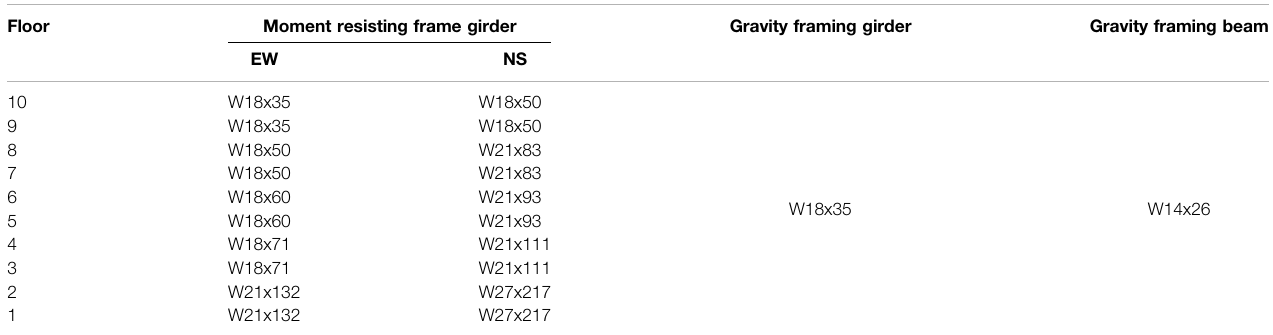
TABLE 1 | Summary of framing